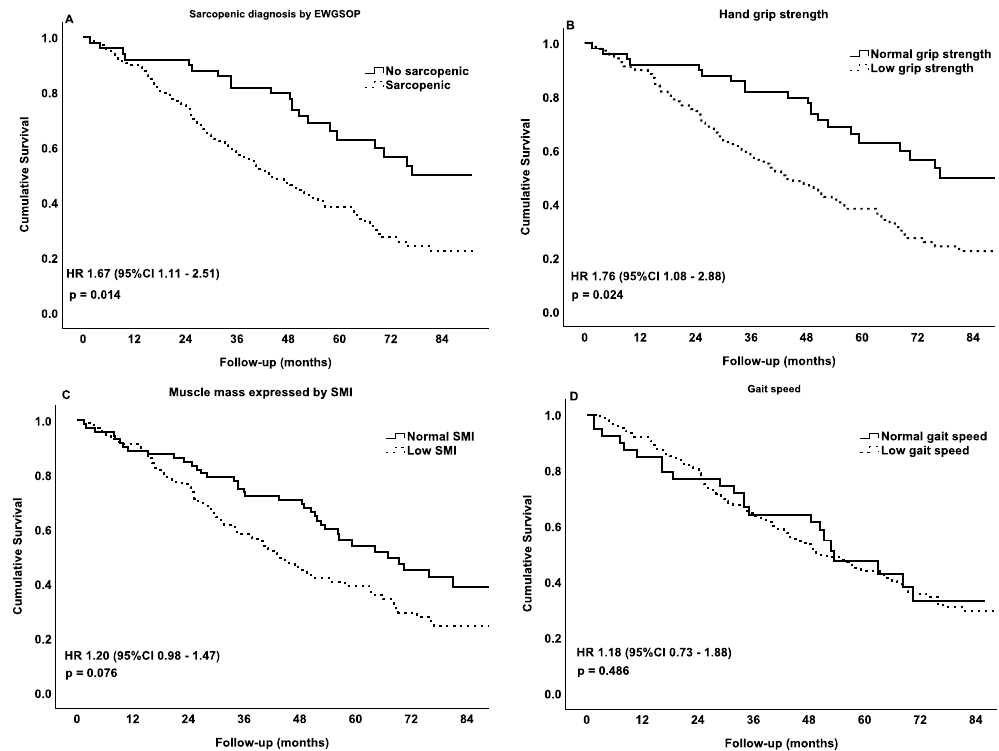
Figure 2. Cox regression of cumulative survival at 7 years of follow-up expressed with the Kaplan–Meier curve ( n = 187). Variables included at discharge. Models adjusted by age, sex and centre. ( A ) Sarcopenia diagnosis by the revised European Working Group on Sarcopenia in Older People; ( B ) low hand-grip strength < 27 kg for men, and < 16 kg for women; ( C ) low skeletal muscle index < 7.0 kg / m 2 for men, and < 6.0 kg / m 2 for women and ( D ) low gait speed ≤ 0.8 m / s.